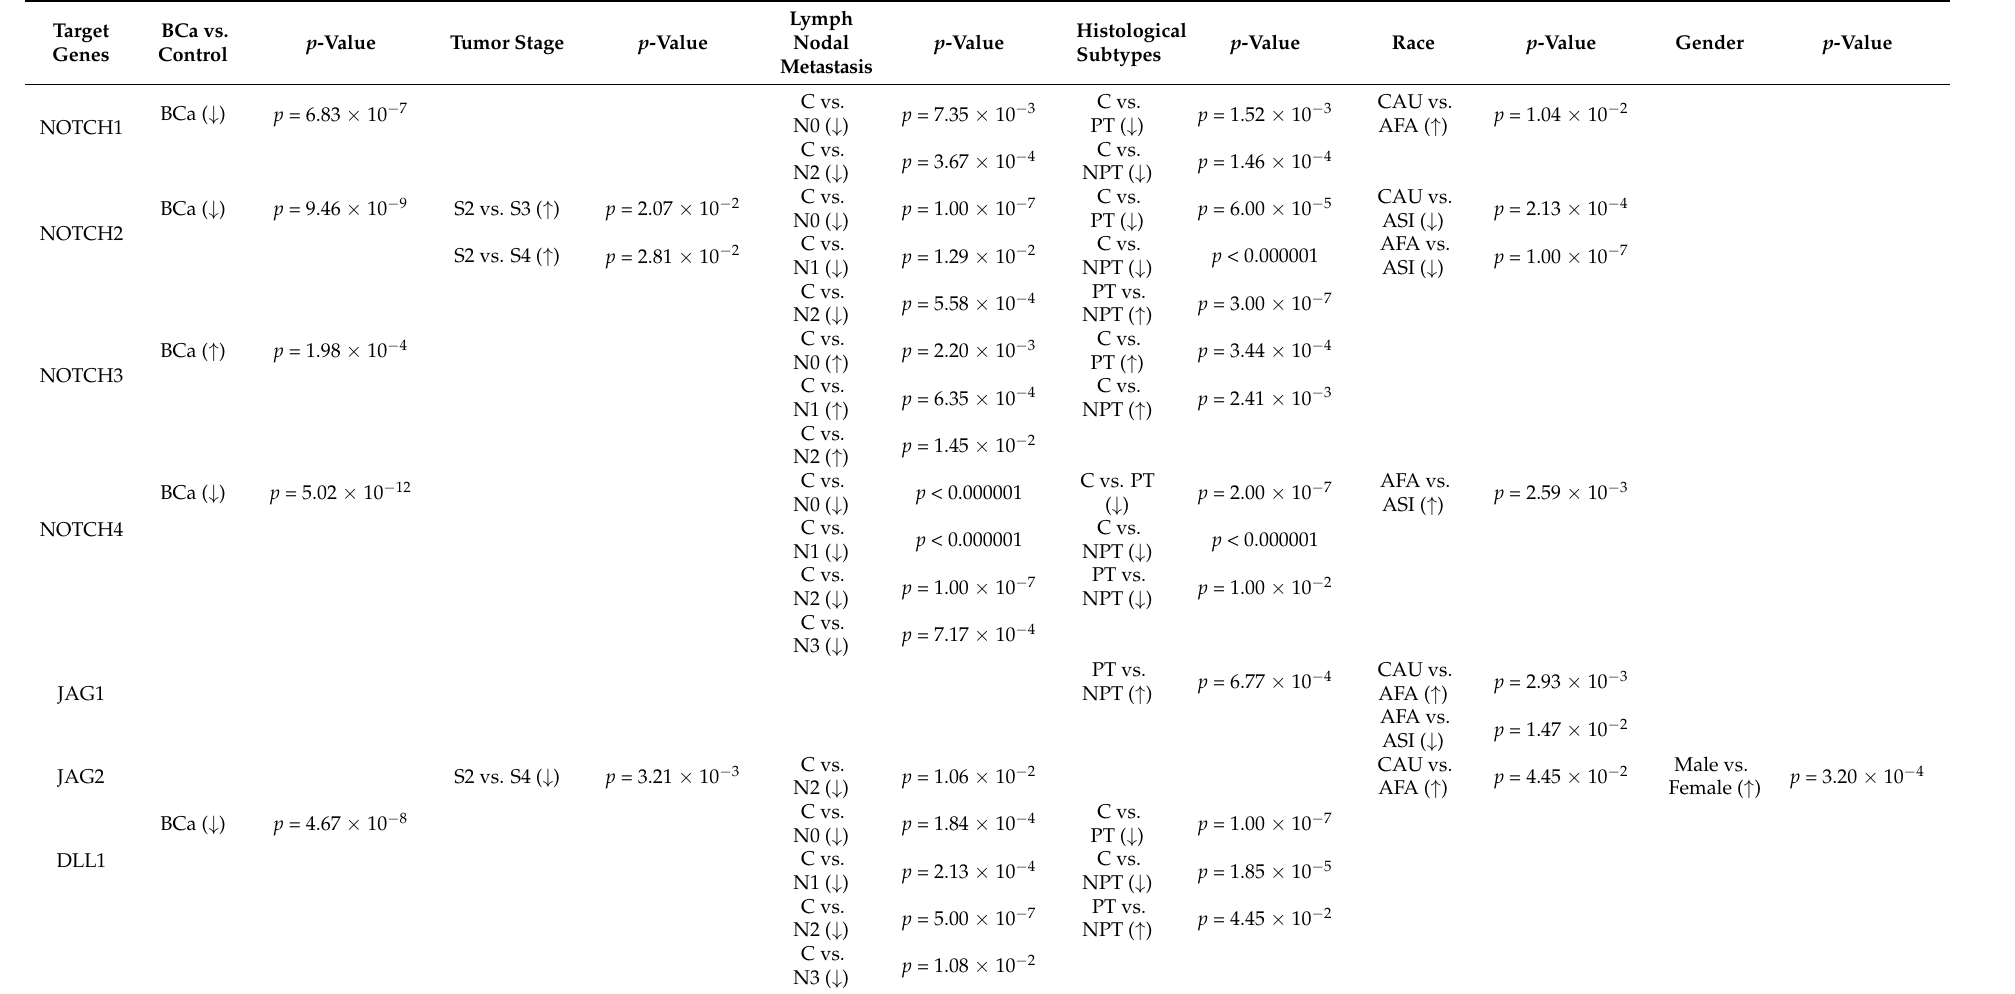
Table 2. Statistically significant difference of expression levels of target genes in subgroups